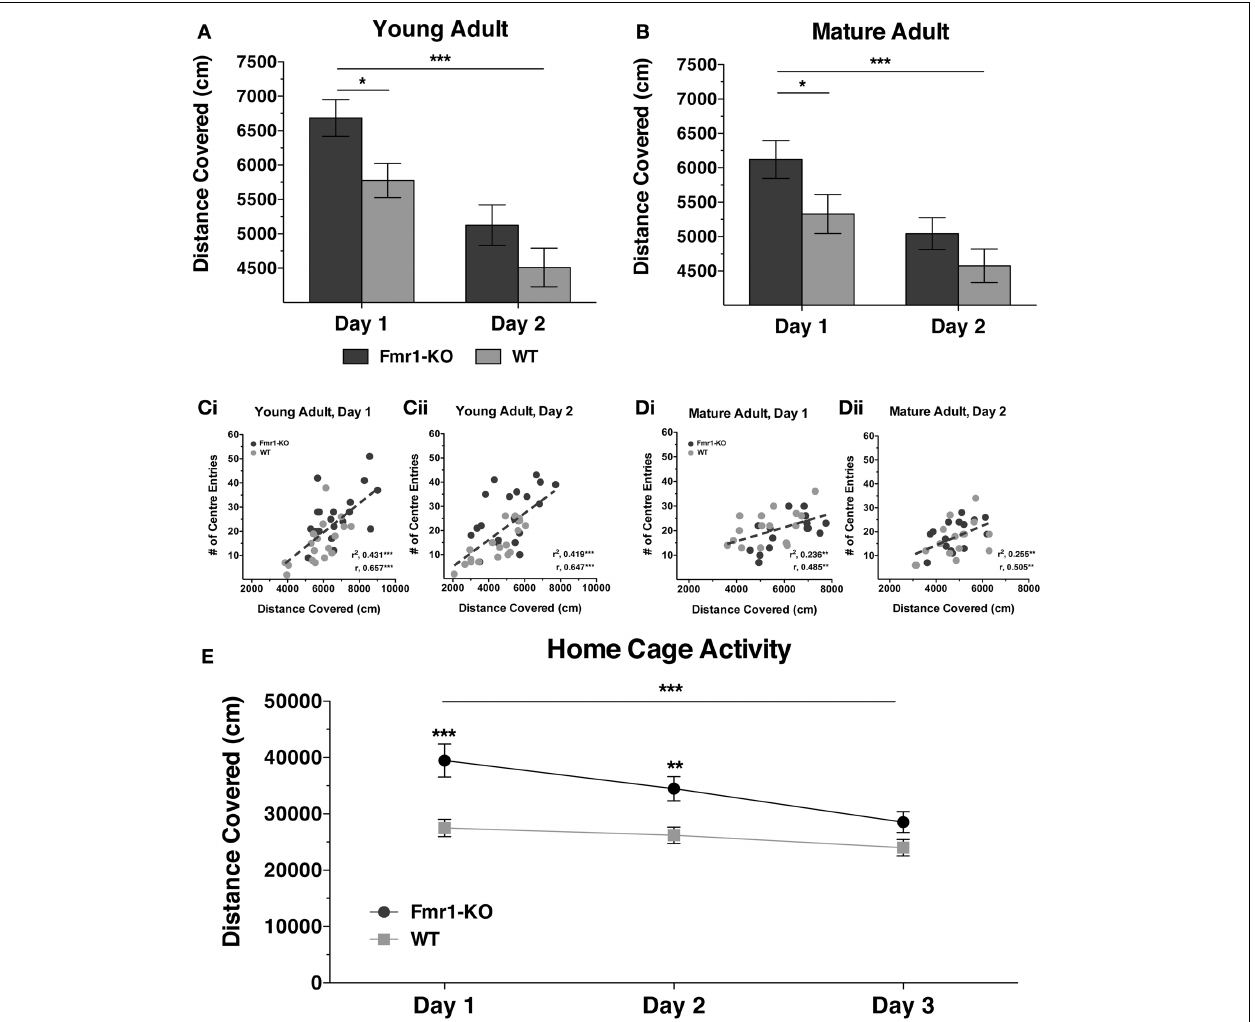
FIGURE 1 | Activity of young and mature adult Fmr1 -KO mice in novel environments. Fmr1 -KO mice covered significantly greater distance than WT age-matched littermates during the first but not the second day of testing in a novel open field arena at 10 (A) and 25 (B) postnatal weeks; values plotted represent means ± SEM. The total distance covered correlated significantly with the number of center entry crossings for both 10 (Ci , ii) and 25 (Di , ii) week old mice during both days of testing; filled circles represent values